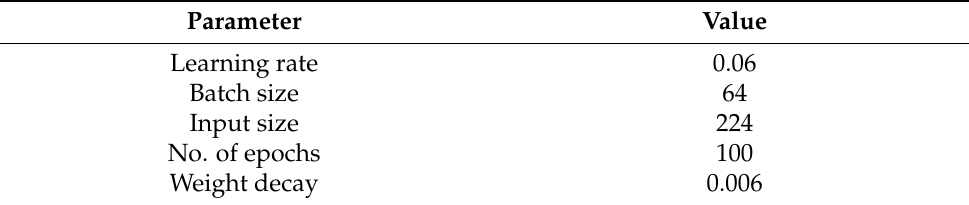
Table 2. Parameters used during